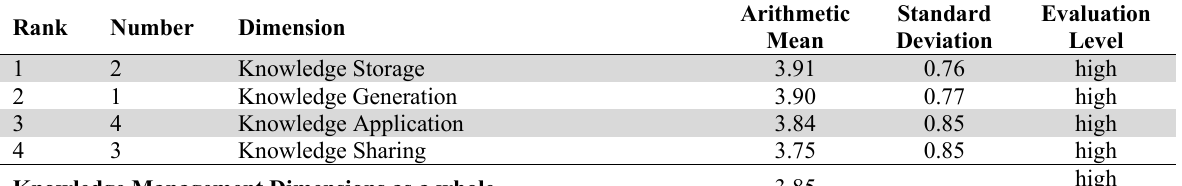
Arithmetic Means and Standard Deviations of Respondents' Answers to “Knowledge Management Pro- cesses” Dimensions (in descending order by arithmetic